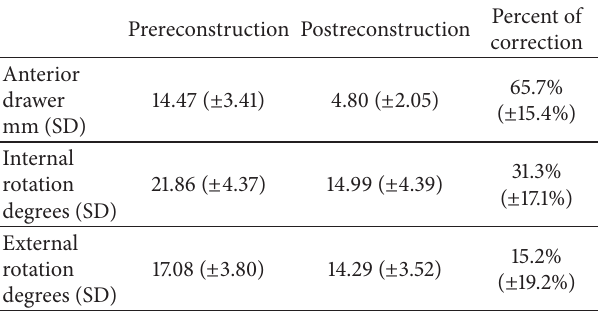
Table 2: Pre- and postreconstruction stability